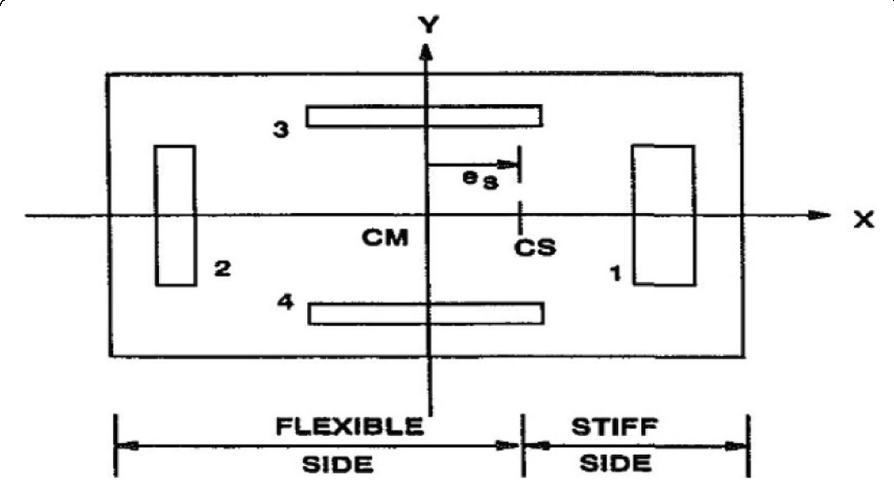
Fig. 1 Stiff side and flexible side elements [5] (stiff side elements: wall (1)/flexible side elements: Wall 2, 3, and